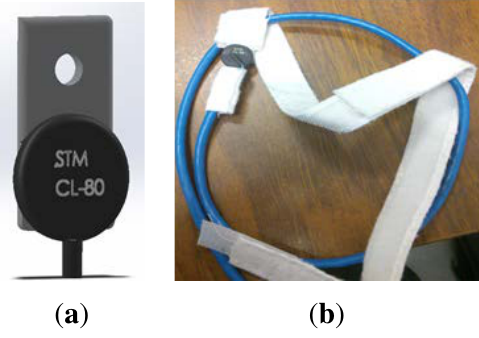
Figure 3. BT prototype: ( a ) BT sensor based on an NTC-CL80 thermistor and ( b ) elastic band with the thermistor located to acquire the patient’s